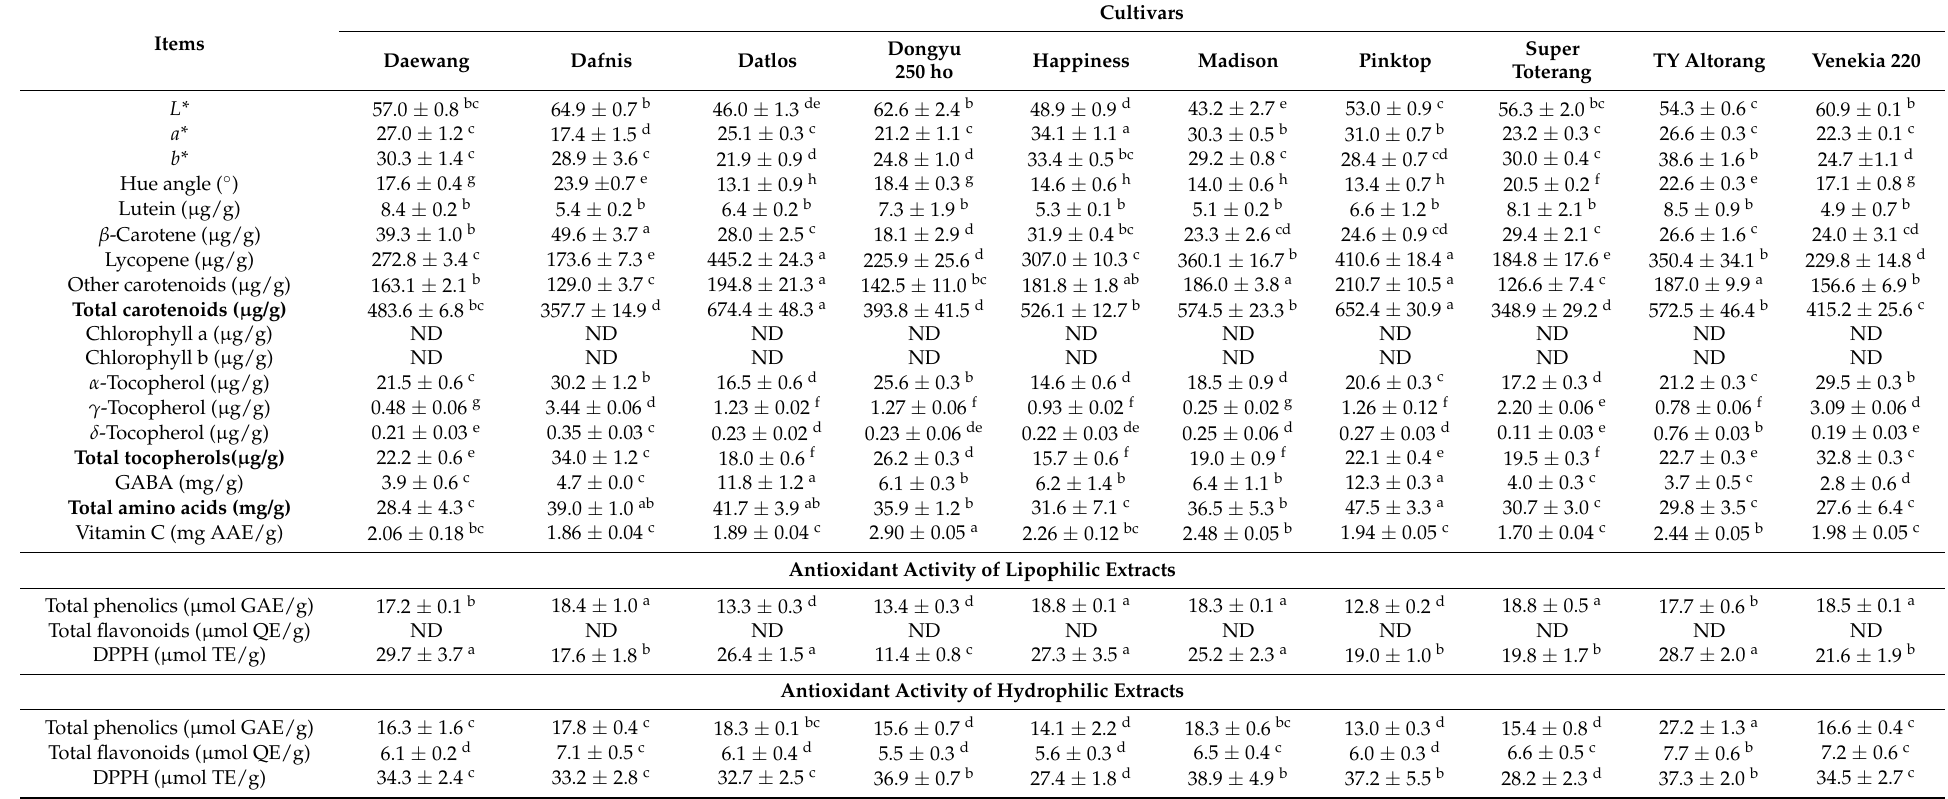
Table 2. Hunter values and antioxidant constituents in the tomato pulp of eighteen tomato cultivars, and their antioxidant